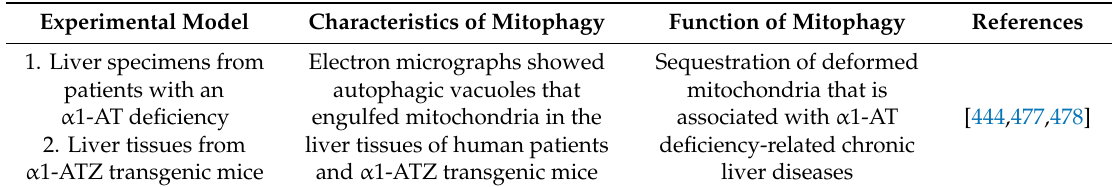
Table 2. Summary of the roles of mitophagy in liver